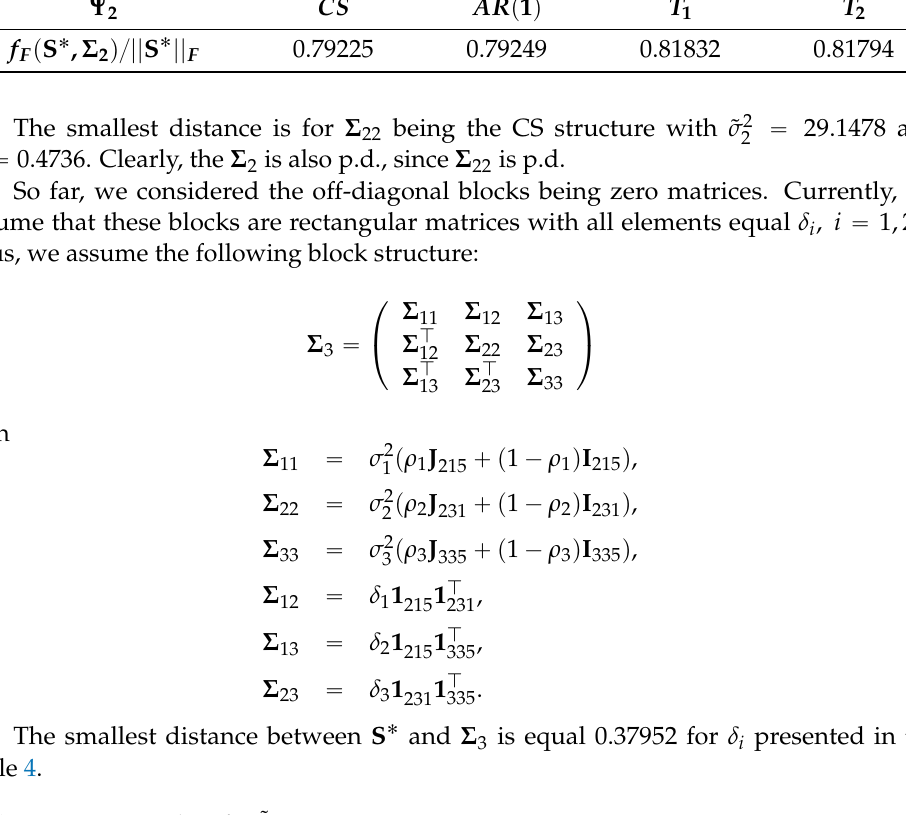
Table 4. Parameter values for ˜ δ i , i “